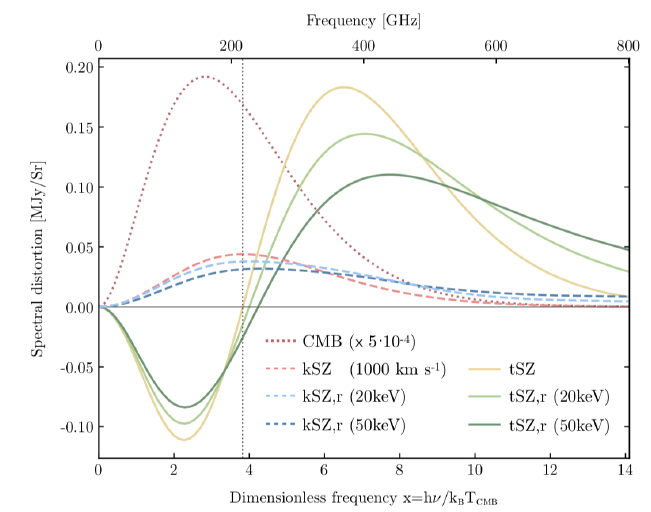
Figure 1. Figure reproduced from Fig 2 in [15], quoting the a ff erent caption : " Thermal (solid) and kinematic (dashed) SZ spectra, including relativistic corrections for various temperatures. We assumed an optical depth τ e = 10 − 2 and an overall Compton parameter y = 10 − 4 . The dotted, dark red curve illustrates the shape of the unscattered CMB spectrum, which for comparison was scaled by a factor of 5 10 − 4 . " ×